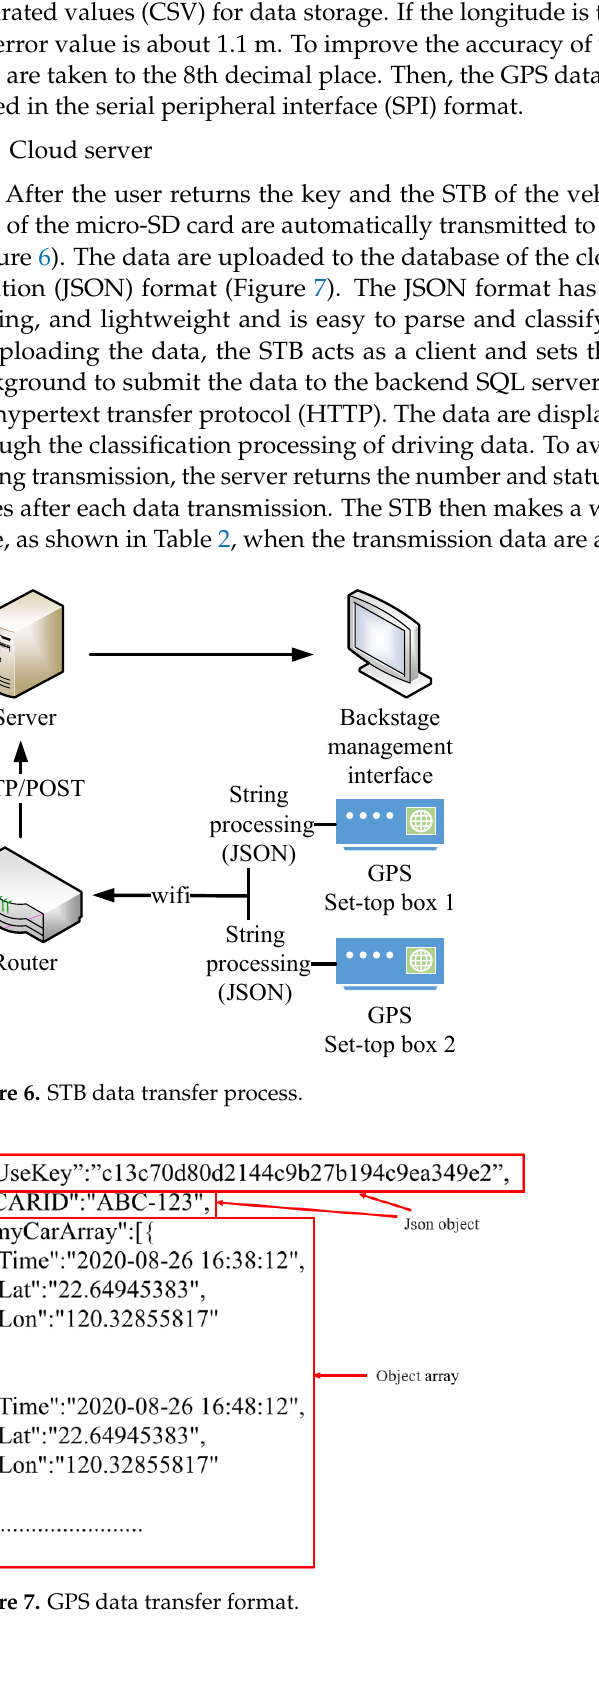
Figure 5. Schematic diagram of vehicle driving state determination.